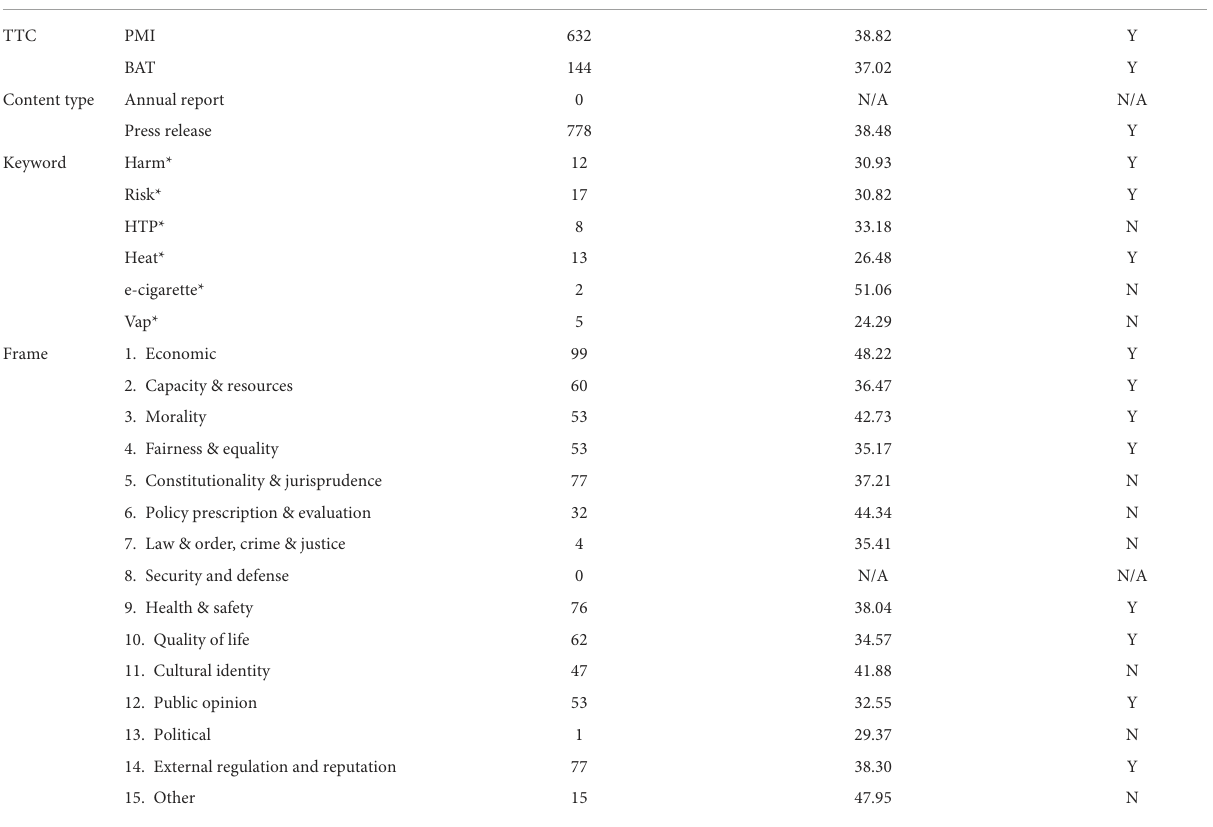
TABLE 6 Instances of more than 20% raw disagreement, split by TTC, content type, keywords and